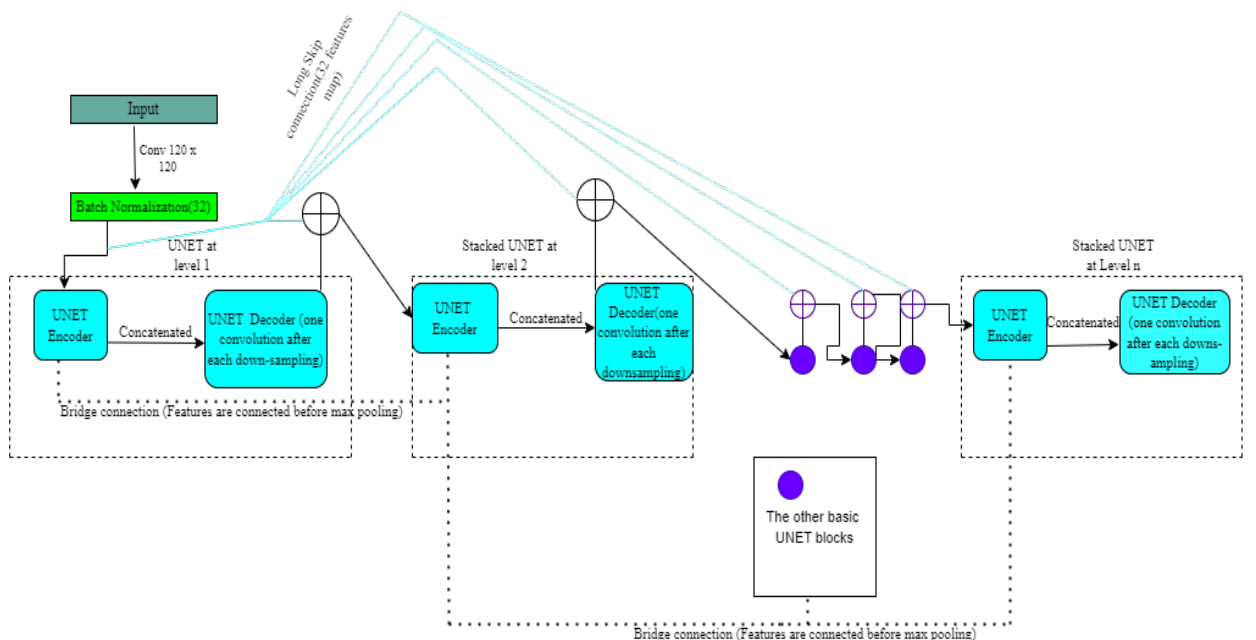
Figure 4. The architecture of SMCSRNET.